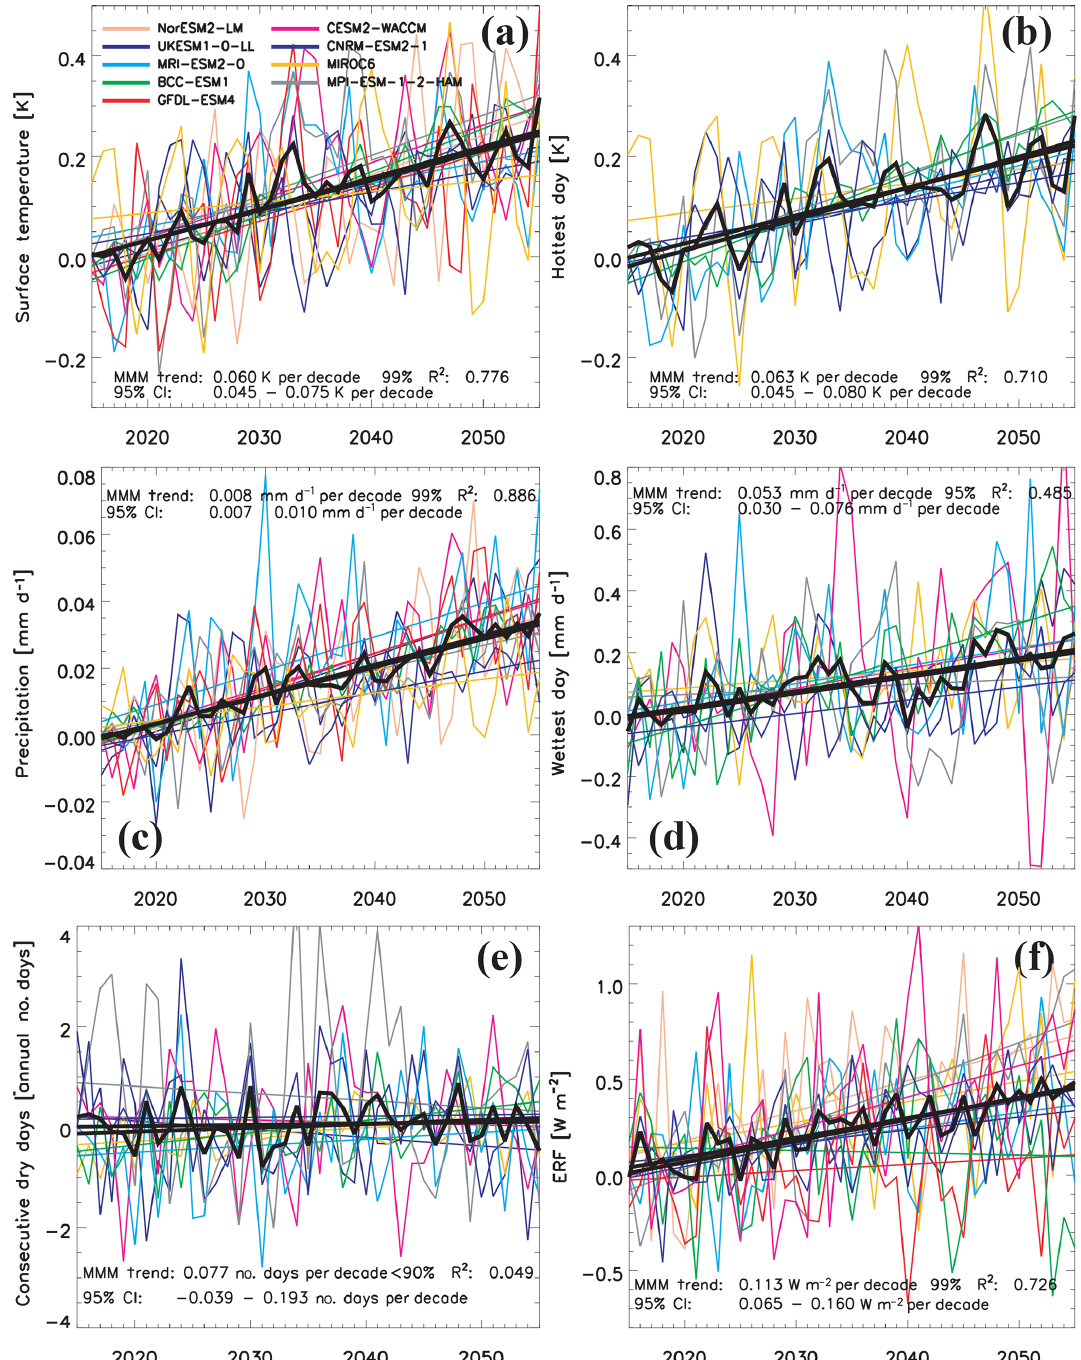
Figure 4. The 2015–2055 time series of global annual mean climate variables due to NTCF mitigation. Panels show (a) surface temperature (K); (b) hottest day (K); (c) precipitation (mmd − 1 ); (d) wettest day (mmd − 1 ); (e) consecutive dry days (annual number of days); and (f) ERF (Wm − 2 ) for NTCF mitigation. The multi-model mean time series and the corresponding trend estimated using a weighted least-squares regression are included as thick black lines. The multi-model mean (MMM) trend, its significance, and R 2 value are also included, as is the 95% confidence interval (CI). Individual model mean trends are also included as defined by the